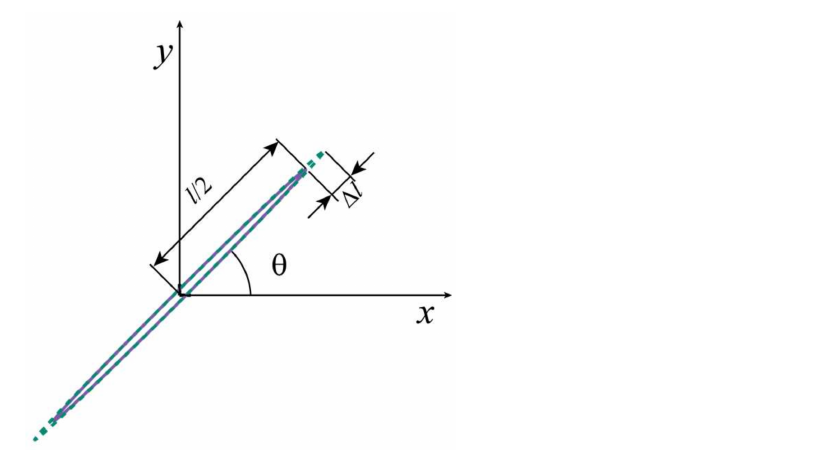
Figure 3. Schematic diagram of crack propagation. The solid line indicates the initial crack, and the dashed line indicates the crack after development. The angle θ increases by a 15 ◦ increment from 0 ◦ to 90 ◦ .